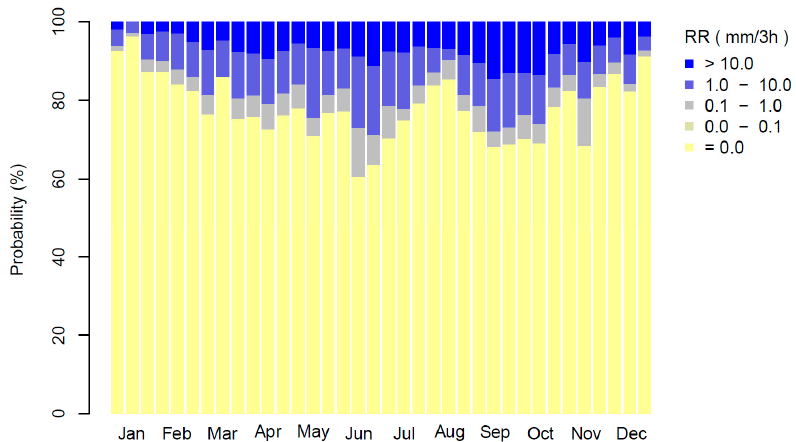
Figure 2. Frequency diagram of precipitation (RR, mm/3h) for Tokyo showing average precipitation classes throughout the year in decadal resolution.